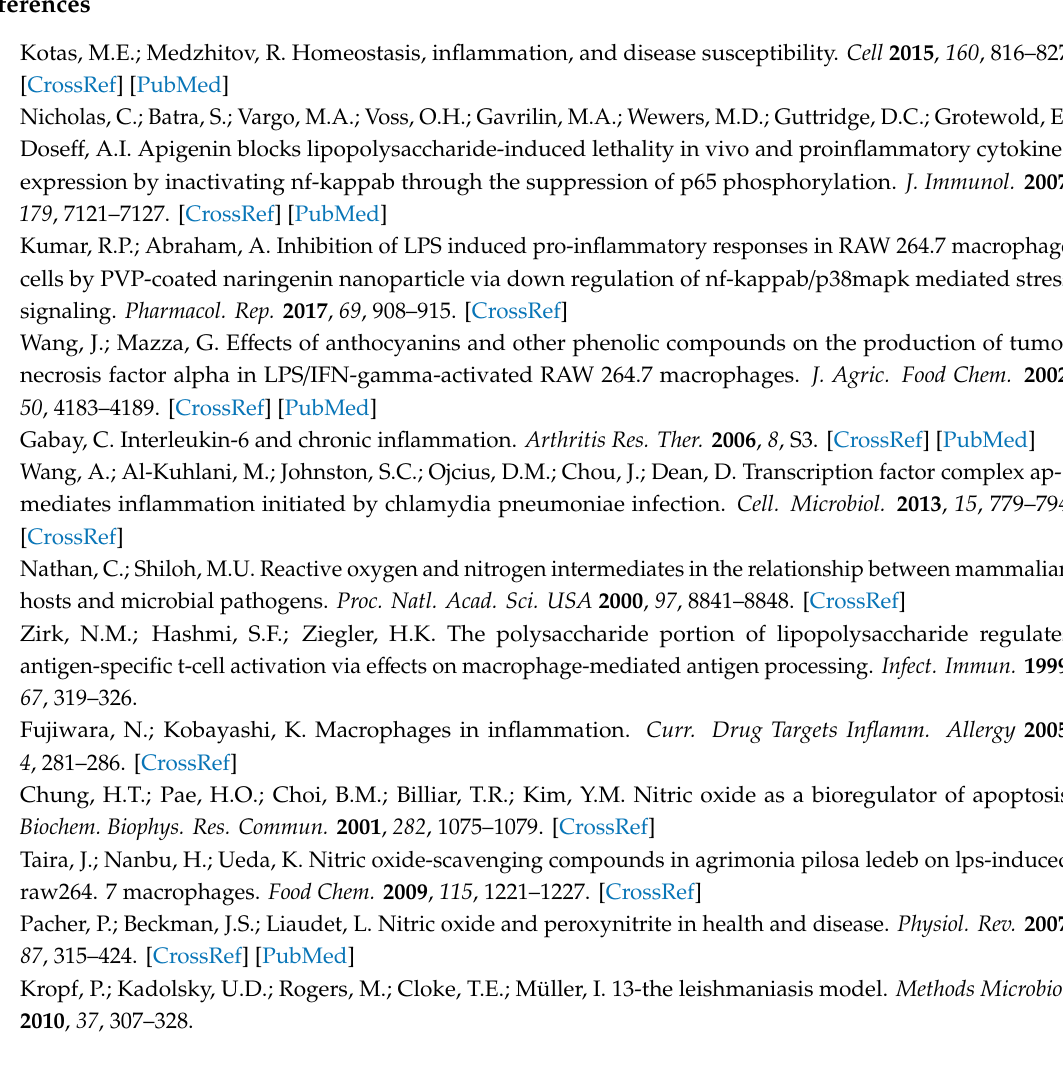
s1, Figure S1: TLC result of subfractions from Fr. F. (A) Fractions before merge (mobile phase is Acetone (A) / Dichloromethane (DCM) = 3:7, v / v ) (B) Fractions after merge (left TLC plate, mobile phase is Ethyl acetate (EA) / DCM = 1:1, v / v ; right TLC plate, mobile phase is A / DCM = 2:8, v / v ). Figure S2: TLC result of subfractions from Fr. F5. Fractions before merge (mobile phase is labeled on the top of TLC plate). Figure S3: The HPLC chromatogram. (A) HPLC chromatogram of Fr. F5b. (B) HPLC chromatogram of Fr. F5e. (B) HPLC chromatogram of Fr. F5f. Figure S4: The NMR spectrum. (A) 1 H NMR spectrum of sitoindoside I in chloroform- d . (B) 1 H NMR and 13 C NMR spectrum of tetrahydroamentoflavone in methanol- d 4 . (C) 1 H NMR spectrum of amentoflavone in acetone- d 6 (D) 1 H NMR spectrum of protocatechuic acid in acetone- d 6